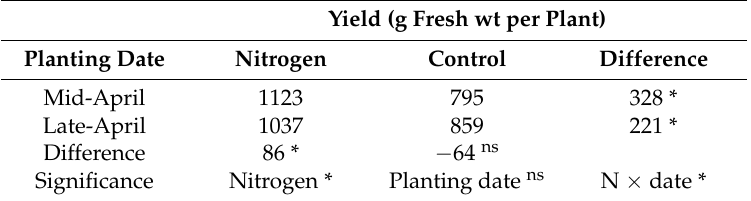
Table 2. Effects of nitrogen fertiliser and planting date on the yield of ‘Festival’ strawberry grown in Queensland, Australia in 2015.